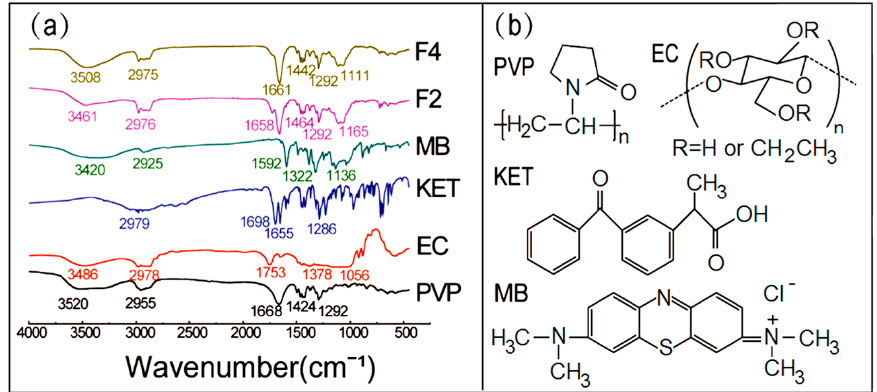
Figure 5. Compatibility investigation: ( a ) ATR-FTIR spectra of the components (MB, KET, EC, PVP) and their side-by-side electrospun nanostructures F2 (Janus beads-on-a-string), F4 (Janus nanofibers); ( b ) molecular structures of PVP, EC, KET, MB.